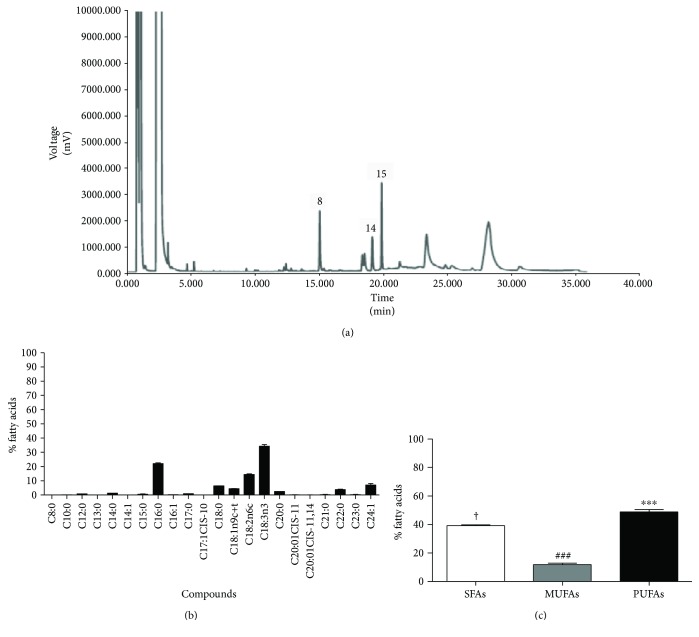
(a) Chromatographic fatty acid profile of Hancornia speciosa leaf samples. (b) Chemical composition of fatty acid methyl esters (FAMEs): caprylic acid (C8:0), capric acid (C10:0), lauric acid (C12:0), tridecanooic acid (C13:0), myristic acid (C14:0), myristoleic acid (C14:1), pentadecanoic (C15:0), palmitic acid (C16:0), palmitoleic acid (C16:1), heptadecanoic acid (C17:0), cis-10-heptadecanoic acid (C17:1), stearic acid (C18:0), oleic acid (C18:1n9c+t), linoleic acid (C18:2n6c), α-linolenic acid (C18:3n3), arachidic acid (C20:0), cis-11-eicosenoic acid (C20:1), cis-11,14-eicosadienoic acid (C20:2), heneicosanoic acid (C21:0), behenic acid (C22:0), tricosanoic acid (C23:0), and nervonic acid (C24:1). (c) Total composition of saturated fatty acids (SFAs), monounsaturated fatty acids (MUFAs), and polyunsaturated fatty acids (PUFAs) of Hancornia speciosa leaf samples. Values are expressed as the mean ± SEM of three independent experiments performed in duplicate. †P < 0.05 compared with the SFA group versus the PUFA group; ###P < 0.001 compared with the MUFA group versus the PUFA and SFA groups; and ∗∗∗P < 0.001 compared with the PUFA group versus the MUFA groups.